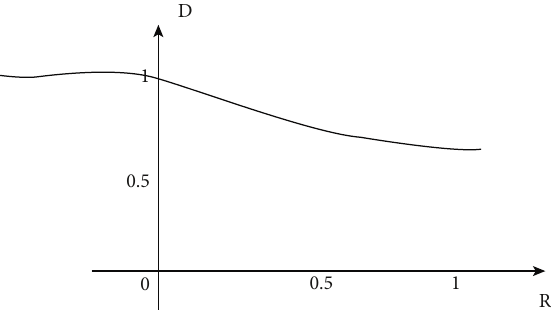
Figure 7: Relationship between the vowel-vowel visual weight value and the difference between the vowel